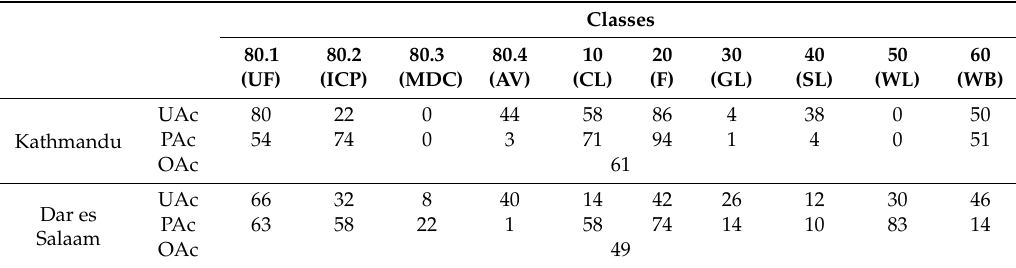
Table 11. User’s accuracy (UAc), producer’s accuracy (PAc) and overall accuracy (OAc) obtained for the enhanced LULC map for both study